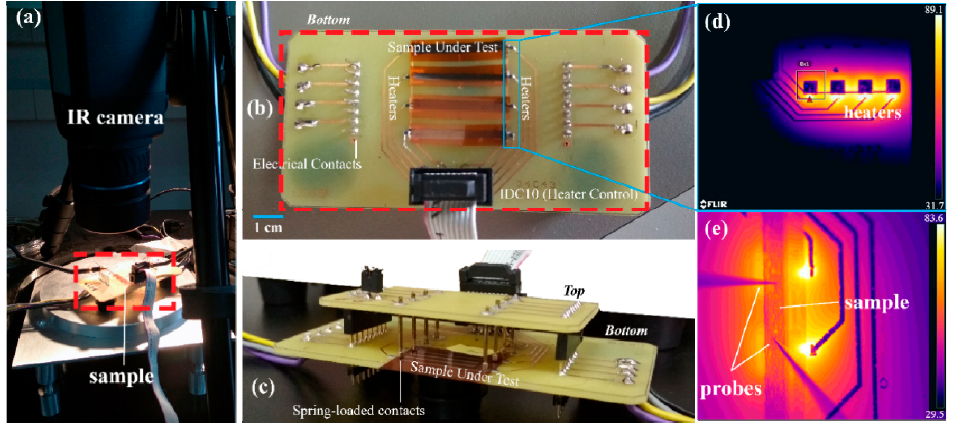
Figure 10. Experimental setup ( a – c ); heating of thermistors with 40 mA each under IR monitoring ( d ); top view from the IR camera with active heaters under a sample and the probes engaged for measurement ( e ).